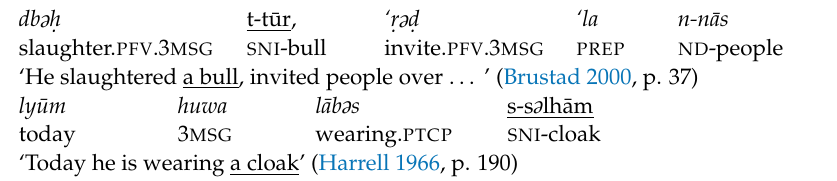
Figure 4. Reference Hierarchy for Egyptian.